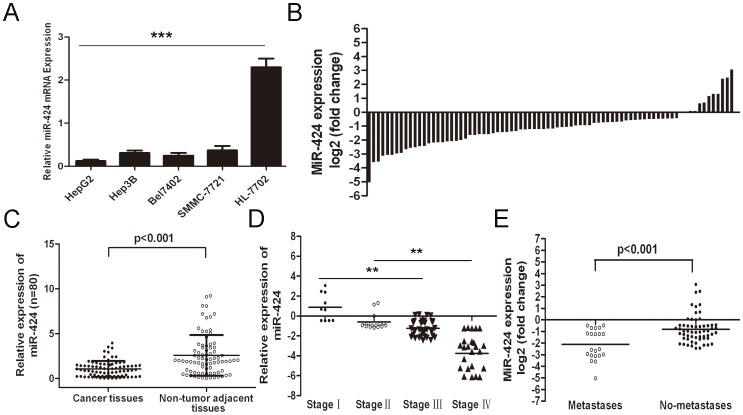
The expression of miR-424 is down-regulated in both primary HCC tissuess and cell lines.(A) qRT-PCR analysis of miR-424 expression in normal hepatopcytes (HL-7792 cells) and HCC cells (HepG2, Hep3B, Bel7402, SMMC-7721). (B) qRT-PCR analysis of miR-424 expression in 80 pairs HCC tissues and their corresponding adjacent nontumorous livers. The expression of miR-424 was normalized to U6 snRNA. (C) Relative miR-424 expression levels in HCC tissues and adjacent normal regions; (D) and (E) Statistical analysis of the association between miRNA level, pTNM stage (I, II, III and IV) and pM stage (No metastasis and Metastasis, respectively); *p<0.05, and **p<0.01.